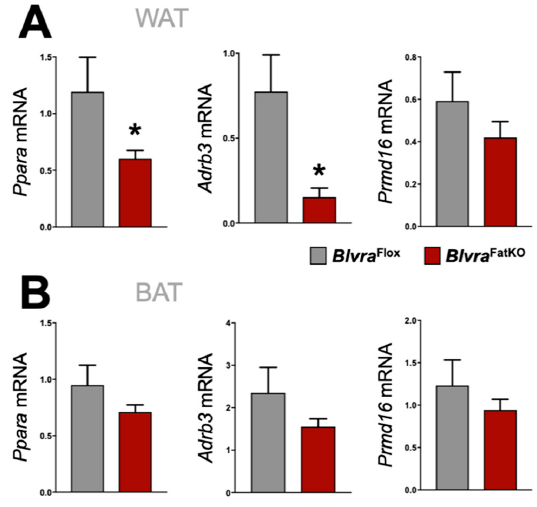
Figure 6. Beiging gene marker expression in WAT and BAT from Blvra Flox and Blvra FatKO mice fed a high-fat diet. Ppara , Adrb3 , and Prmd16 mRNA expression in WAT ( A ) and BAT ( B ). *, p < 0.05 (vs. Blvra Flox ). n = 4/group Blvra Flox ; n = 5/group Blvra FatKO . (vs. Blvra Flox ). n = 4 / group Blvra Flox ; n = 5 / group Blvra FatKO